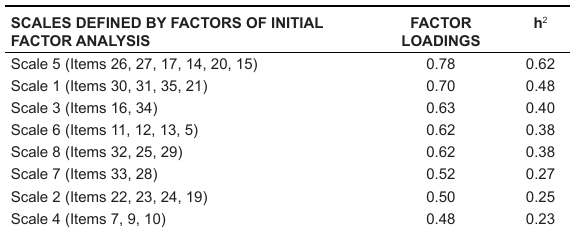
TABLE 2 Factor matrix of the second factor analysis SCALES DEFINED By FACTORS OF INITIAL FACTOR